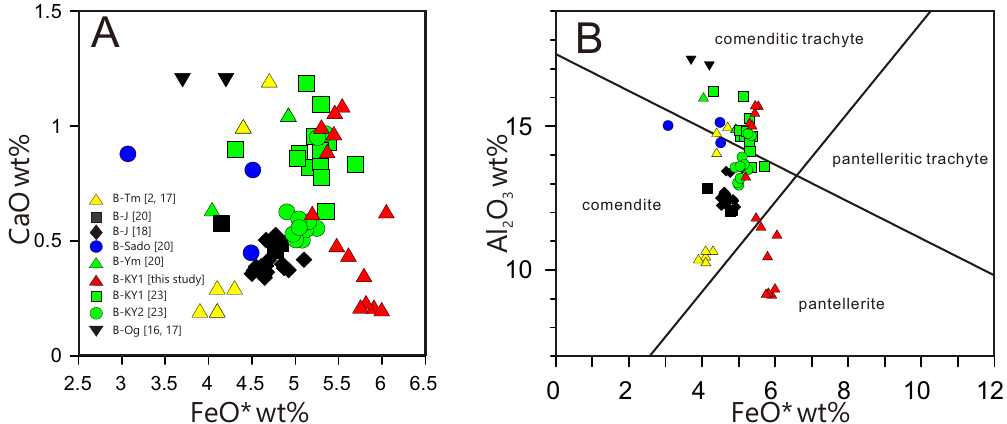
Figure 8. Major element variation diagram of B-KY1 tephra in the ODP 794A core and other Baekdusan tephra samples (Data from [2,16–18,20,23]). ( A ): Ca versus FeO*, ( B ): Al 2 O 3 versus FeO* (Peralikine classification diagram adapted from